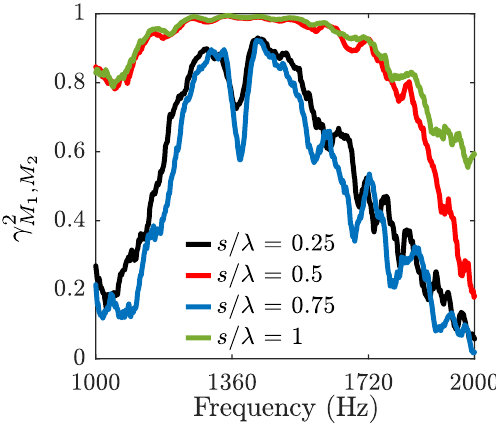
Figure 11. Coherence of acoustic signal from microphone M1 and M2 for different spacing configura- tions between 0.25 < s / λ <